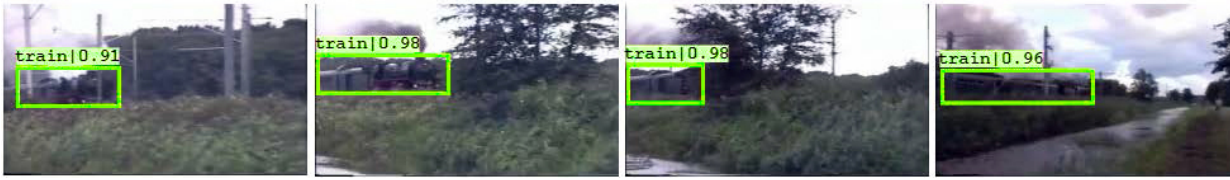
Figure 4. The detection result of the proposed